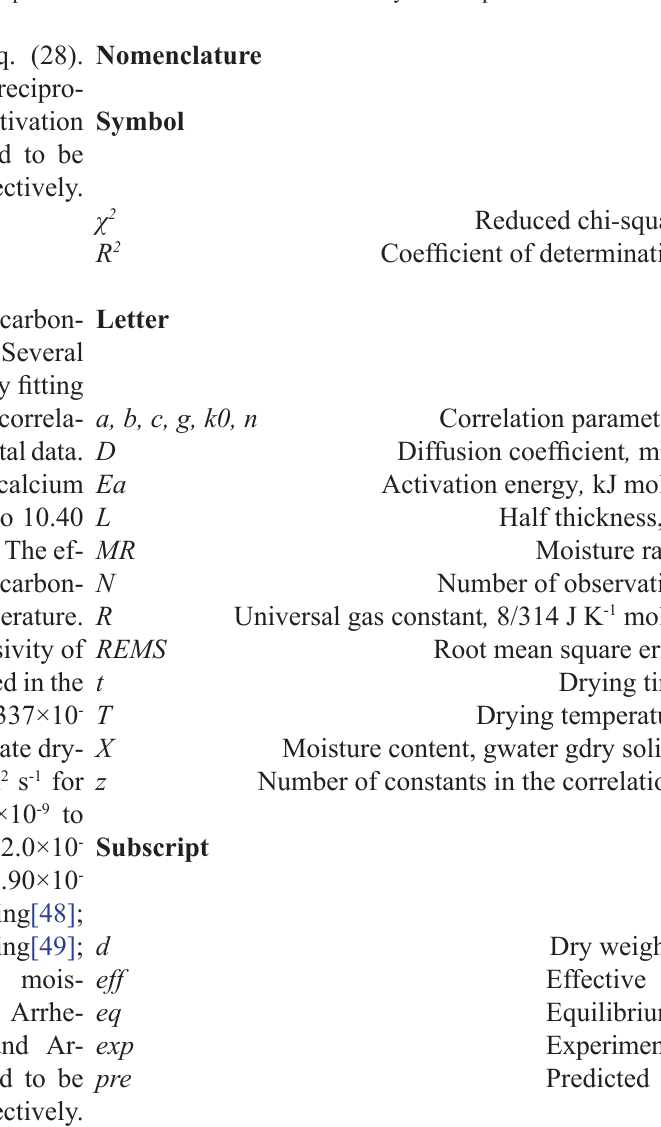
Fig. 4. Arrhenius-type relationship between the effective moisture diffusivity and